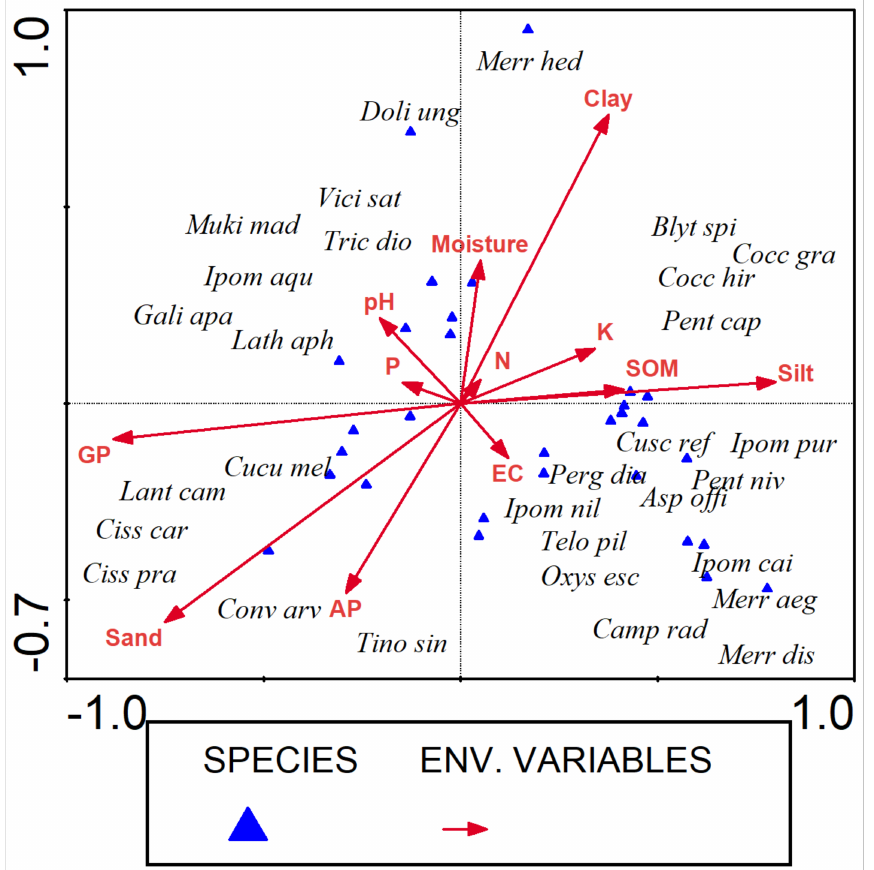
Figure 7. CCA bi-plot shows the relationship between climbers, anthropogenic pressure (AP), grazing pressure (GP), and edaphic variables. The red vectors represent the variables (anthropogenic pressure, grazing pressure, and edaphic factor), while the text represents the code of the species